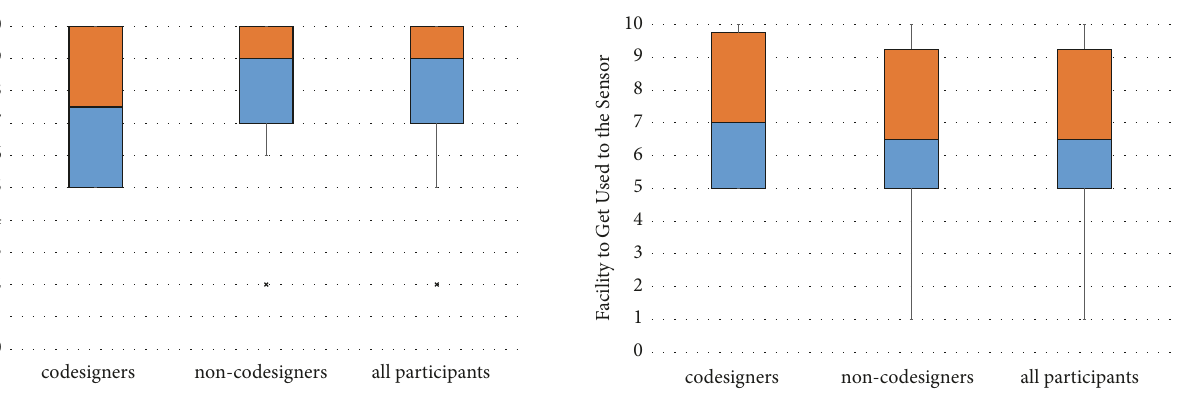
Figure 16: Answers from topic 17 of Table 9: this topic measures the facilityofusersongettingusedtothegesturesrequestedinthegame.